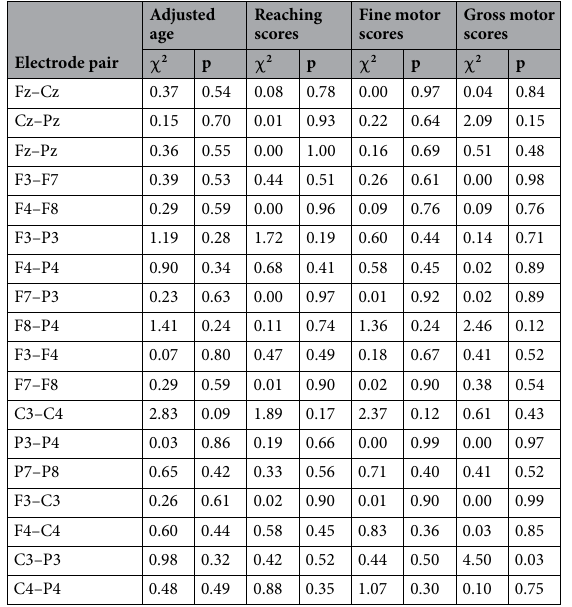
Table 3. Likelihood ratio tests for changes in mean alpha coherence across adjusted age (days), reaching skill level, fine motor scores, and gross motor scores, for 18 electrode pairs. Alpha value of 0.05/18 was selected for the statistical